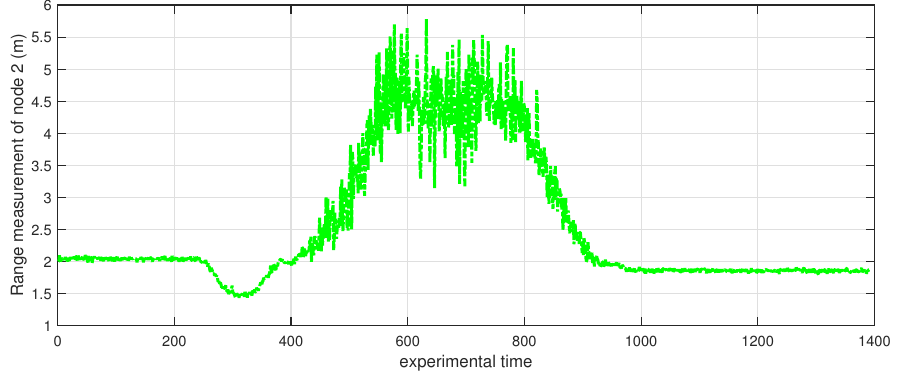
Figure 10. Range measurement of node